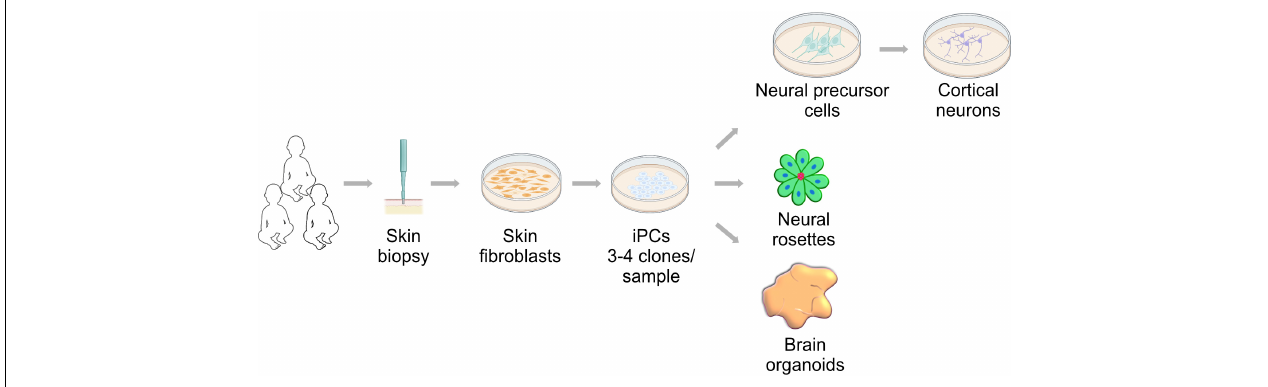
FIGURE 2 | Neural development research approach utilizing induced pluripotent stem cells (iPSCs). Skin fibroblast can be derived from patients and controls by a minimally invasive biopsy. These fibroblasts can be reprogrammed using the Yamanaka factors into induced pluripotent stem cells. iPSCs can generate neural cells in two- and three-dimensional cultures. These approaches are powerful tools to study of neural development in health and mitochondrial disease